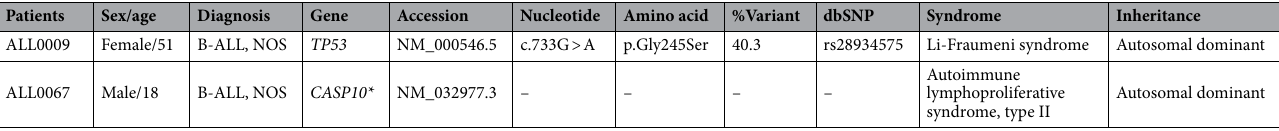
Table 2. Germline pathogenic/likely pathogenic variants identified in Korean ALL patients. *Exonic deletion, exon 6-exon